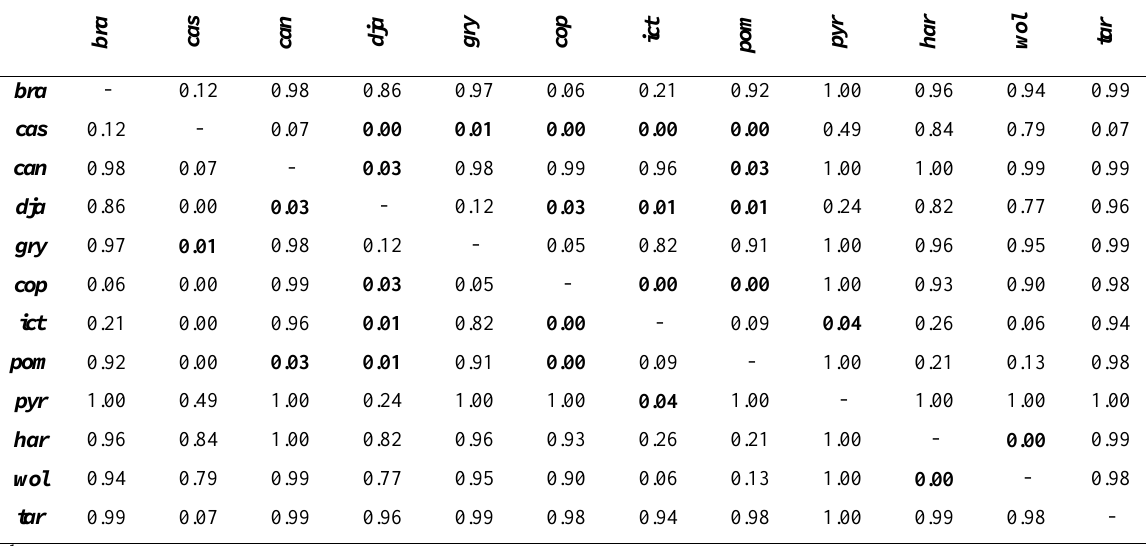
Table 2. P Values for associations between serovar 1 pairs of Leptospira in samples with titers higher than the upper limit of confidence interval of titer distribution, calculated by the Chi- square or Fisher test, according to the number of observations, Botucatu, 2003.